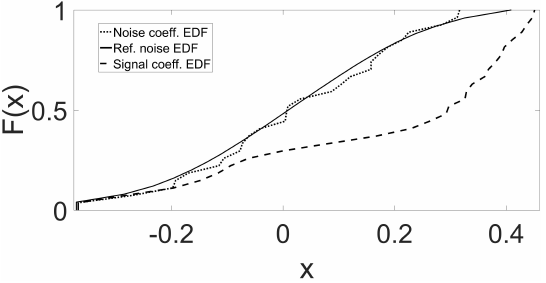
( k ) ( t ) is reference Gaussian CDF 0